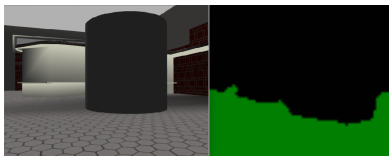
Figure 3. Example of segmentation result, where a cylinder-style obstacle is detected and segmented from the ground. The segmented ground is shown as the green region at the bottom in the right image.